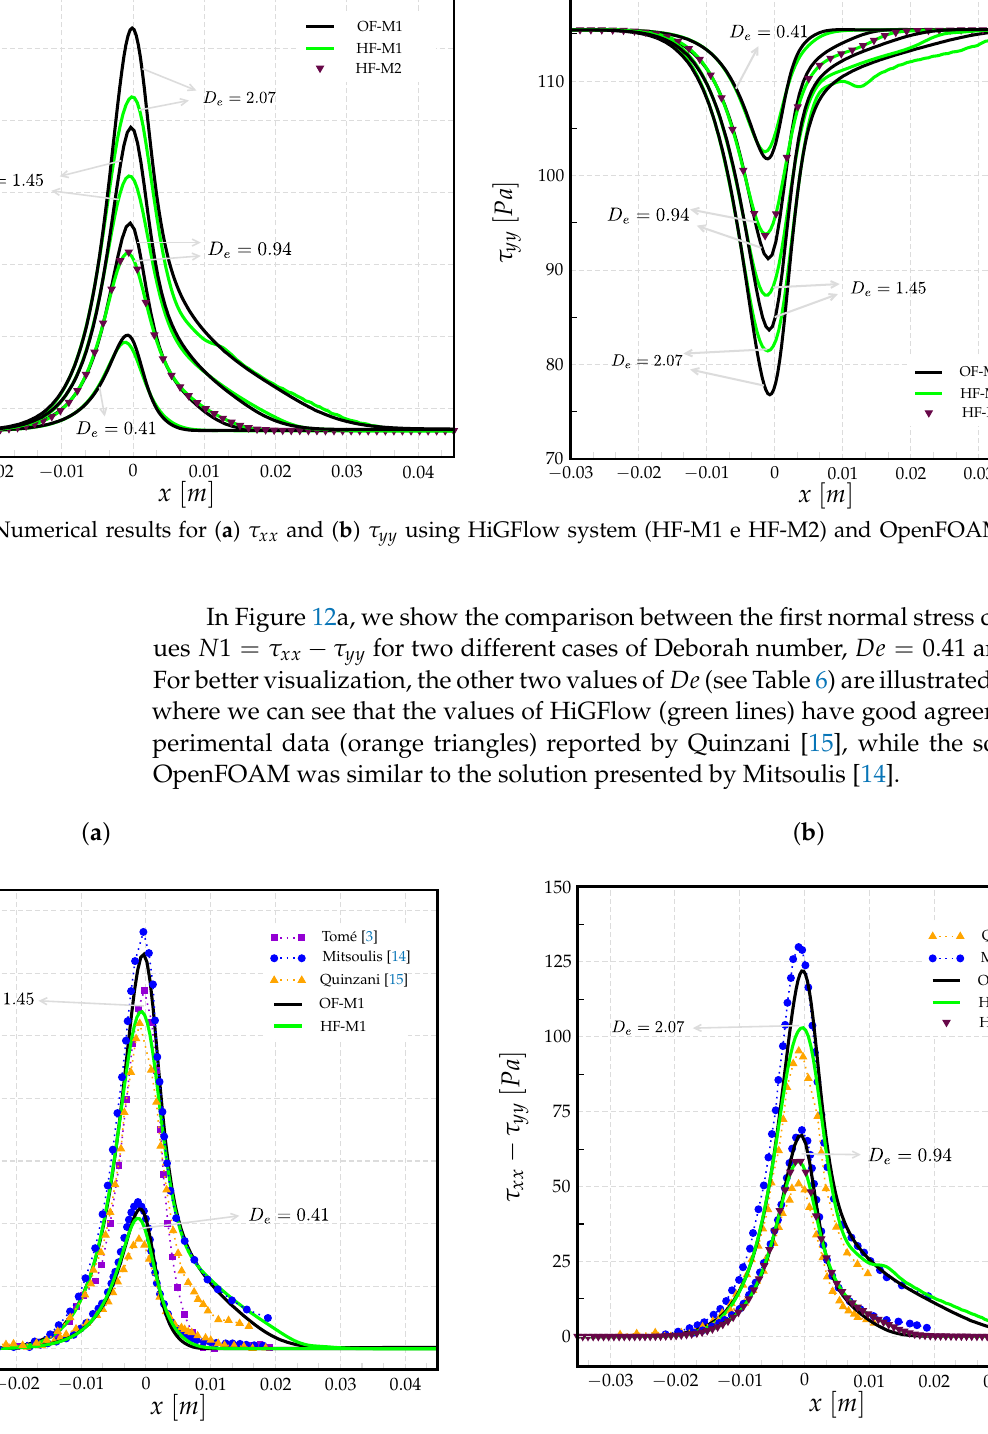
Figure 12. The first normal stress differences N 1: ( a ) for De = 0.41 and De = 1.45; and ( b ) for De = 0.94 and De =